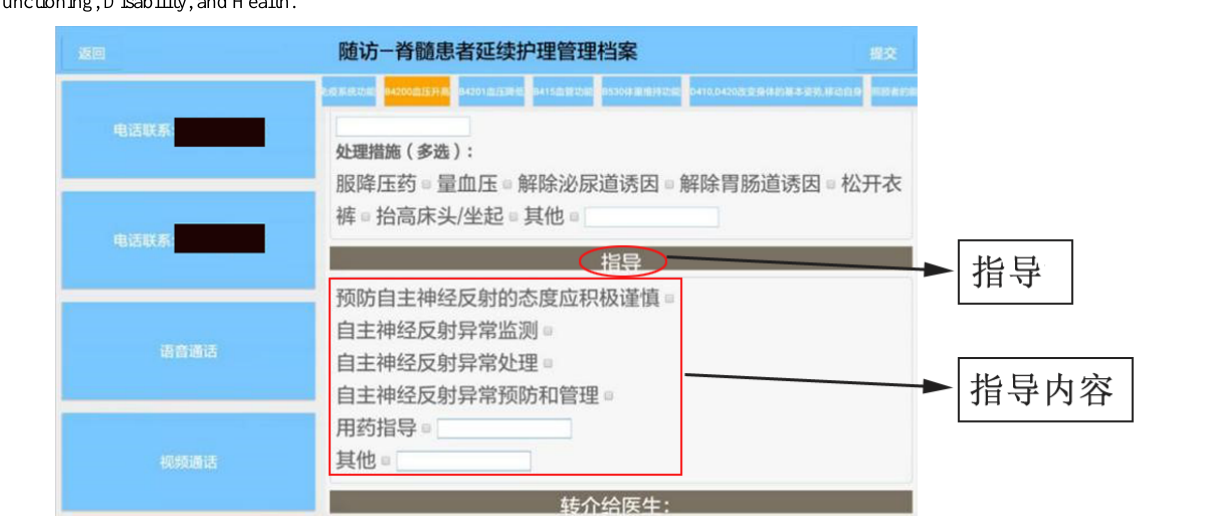
corresponding members of the multidisciplinary team (eg, rehabilitation physician, physical therapist, or occupational therapist) through the app. The team members were required to log in to the app within 3 days and handle the referral problems by contacting the patients. In the end, the physician or